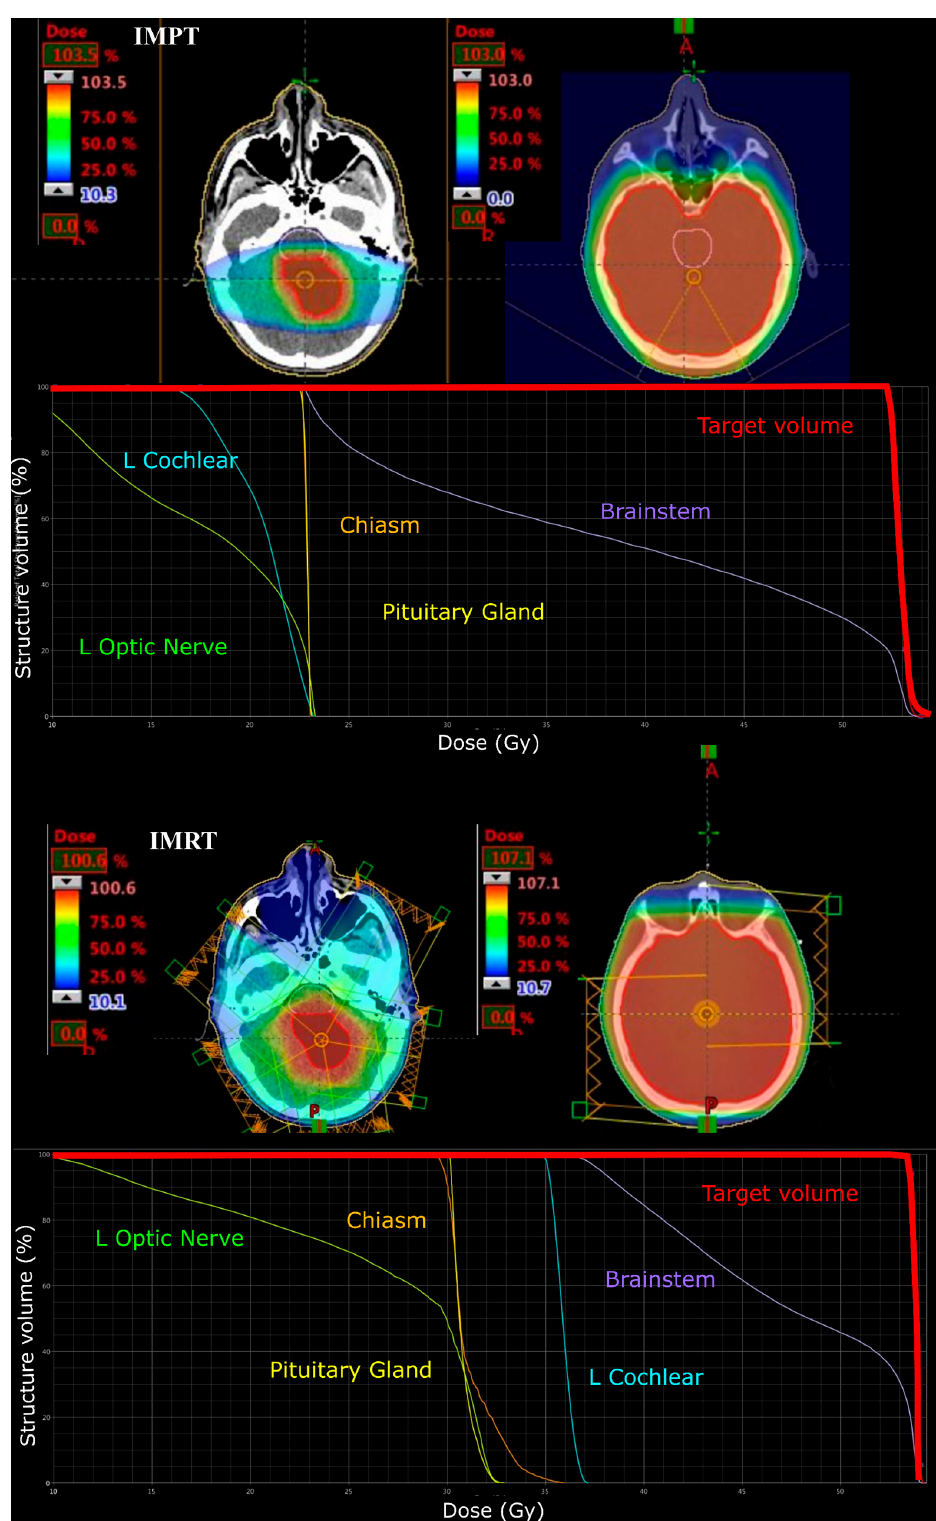
Figure 3. Colourwash dose distributions and dose–volume histograms for a 13-year-old male with infratentorial medulloblastoma. Typical planning beam arrangement viewed on axial CT images for IMPT tumour bed (top left) and craniospinal (top right) and IMRT tumour bed (bottom left) and craniospinal (bottom right) plans. Respective dose–volume histograms are shown below.